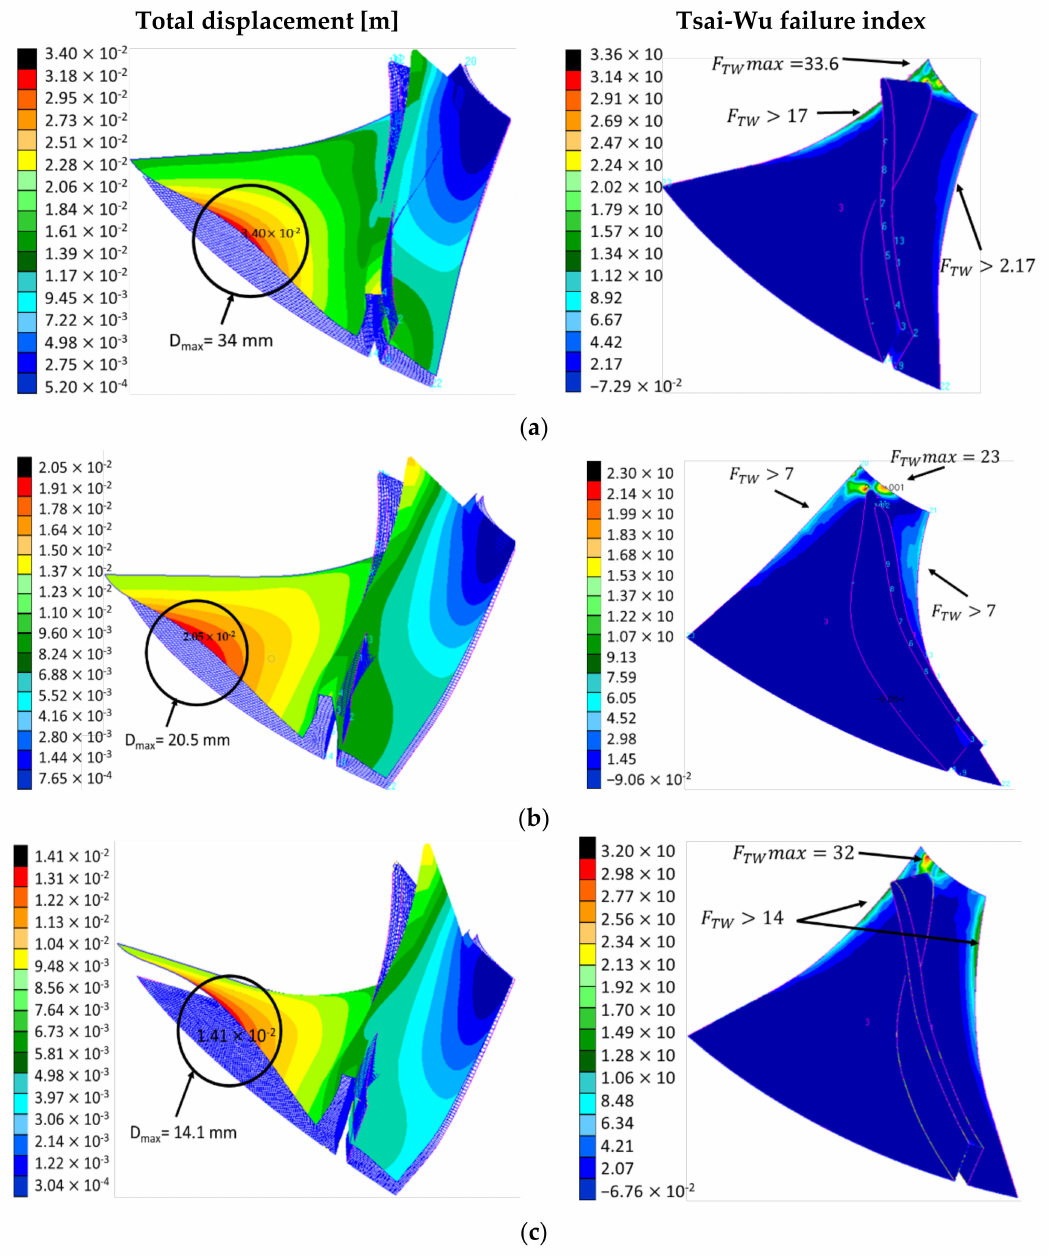
Figure 8. Distribution for the total displacement and Tsai-Wu failure index for the blade modelled with ( a ) 4 composite layers; ( b ) 6 composite layers; ( c ) 8 composite